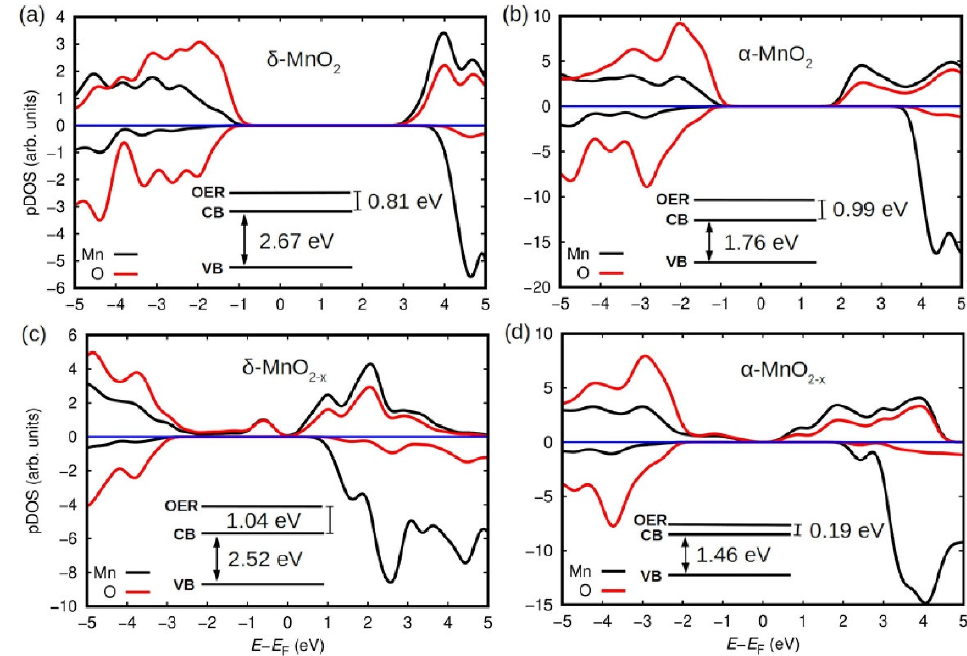
Figure 16. Theoretical estimation of the electronic band structure properties of ( a ) δ - and ( b ) α -MnO 2 and of ( c ) δ - and ( d ) α -MnO 2-x based on first-principle DFT calculations. The spin-up (spin-down) electronic density of states is represented with positive (negative) values. “OER” stands for the energy level of the oxygen evolution reaction (O 2 /H 2 O), “CB” for the alignment of the conduction band, and “VB” for the alignment of the valence band. (Reprinted from ref. [64] with permission from the Chemical Engineering Journal. Copyright © 2022,